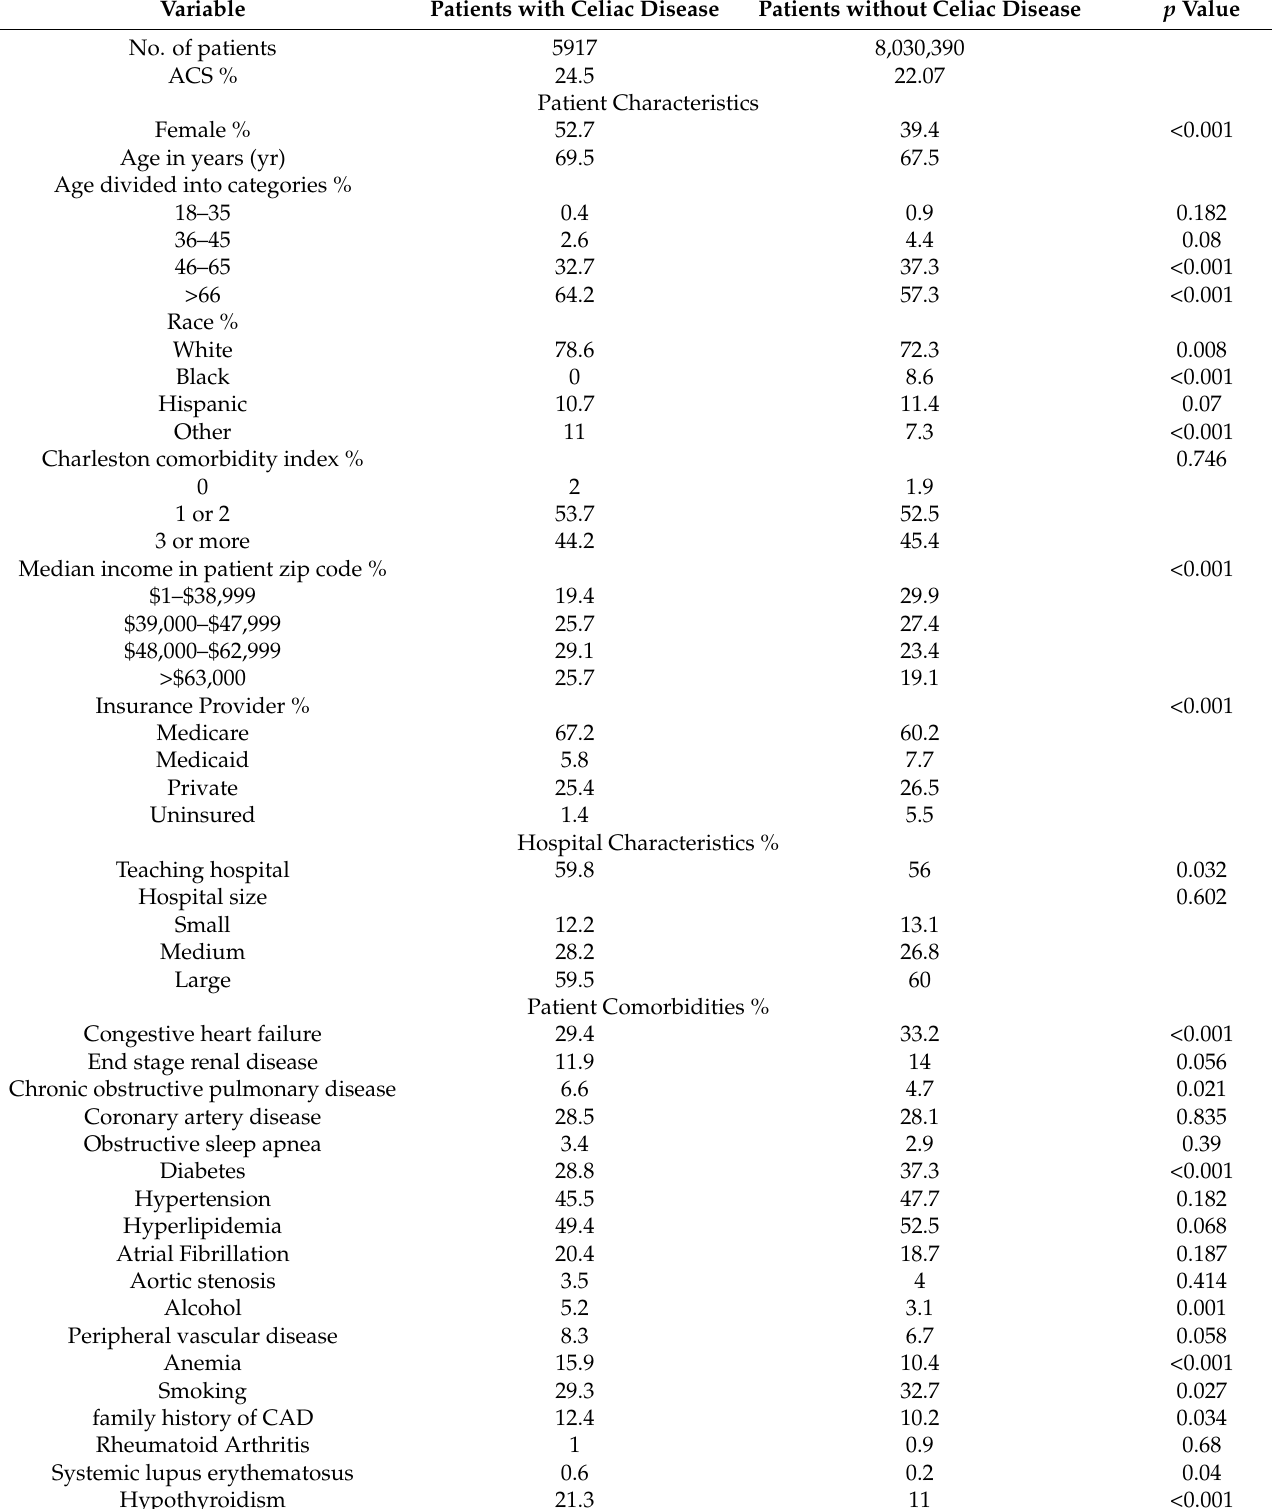
Table 1. Baseline characteristics of patients with ACS and with/without celiac